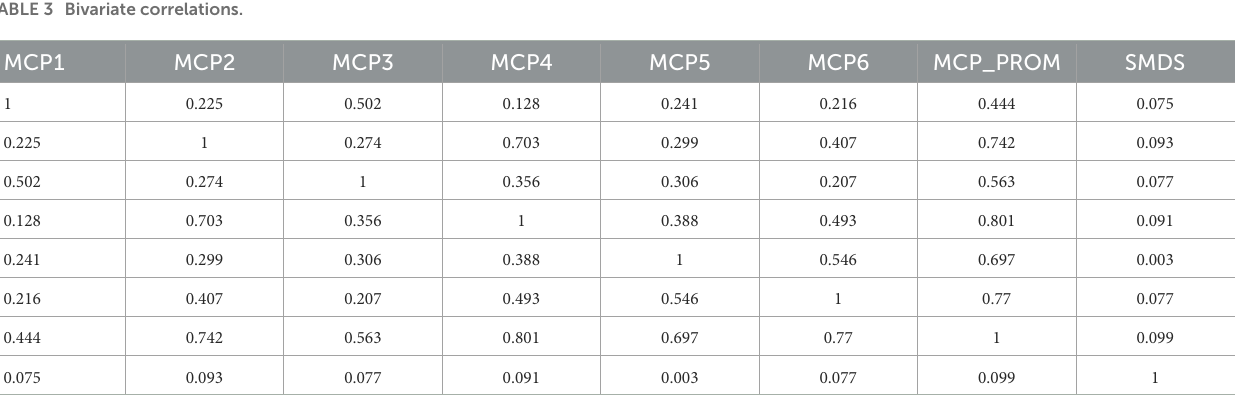
TABLE 3 Bivariate correlations.